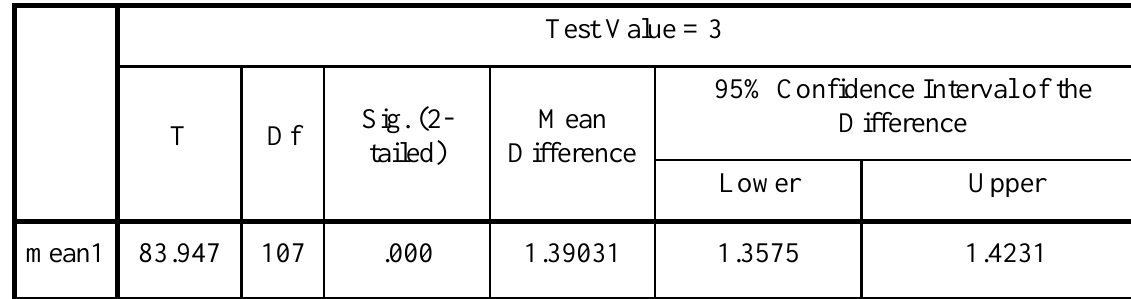
Figure 13. The results of t-test for the data of hypothesis